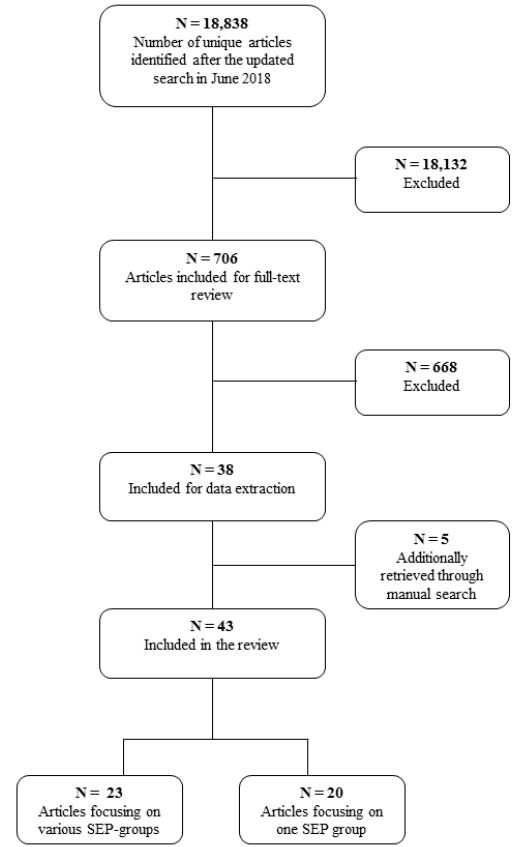
Figure 1. Study selection flow